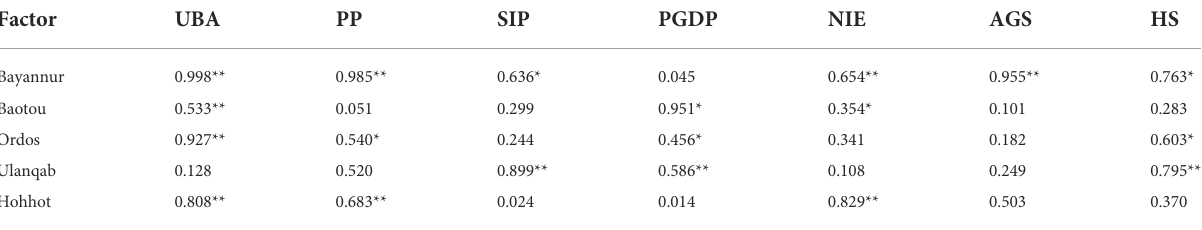
TABLE 5 Explanation Degree of Different Social Factors to PM2.5 Concentration Changes in different cities.